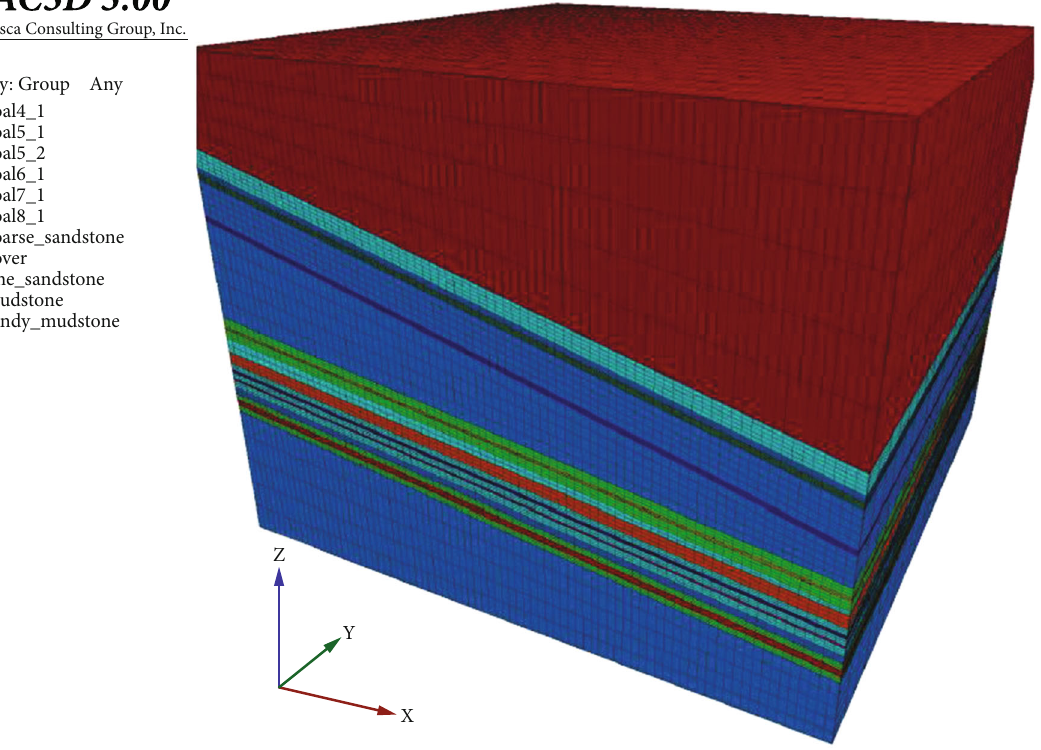
Figure 3: The numerical model realization via FLAC3D